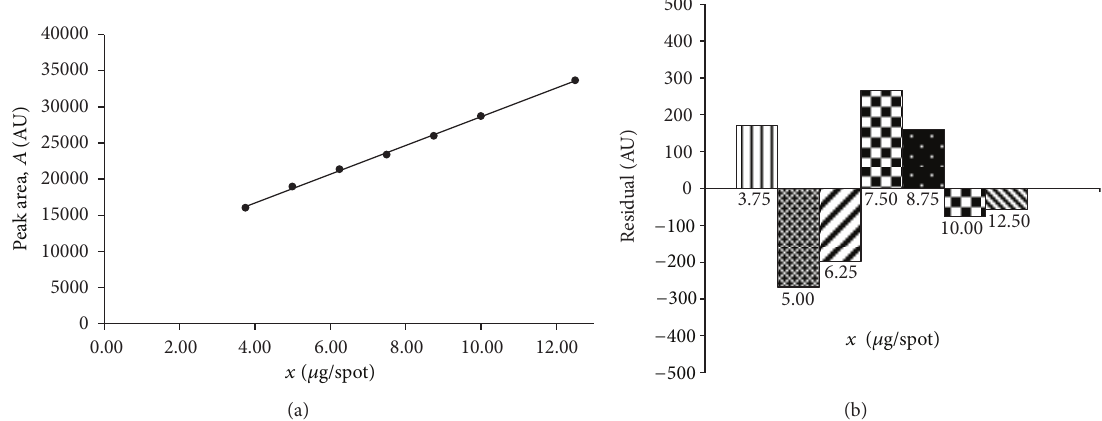
Figure 2: Calibration plot for hydrocortisone acetate (a) and plot of residuals (b) for hydrocortisone acetate in linear working range.